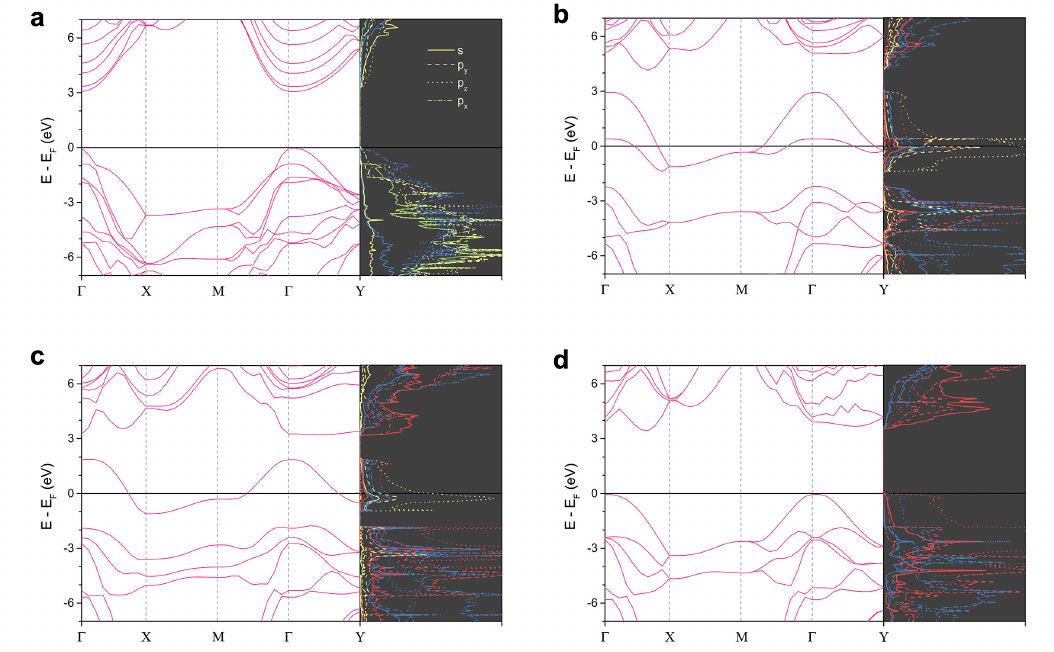
Figure 3. The electronic band dispersions ( left ) and DOS ( right ) of ( a ) C 8 H 4 , ( b ) C 6 N 2 , ( c ) C 5 N 3 and ( d ) C 4 N 4 . The DOS of each atom are presented by blue, yellow, green and red lines for C in , C sf , H and N atoms, respectively. The DOS of each orbital are presented by solid, dashed, dotted, and dash-dotted lines for s, p y , p z , and p x orbitals,